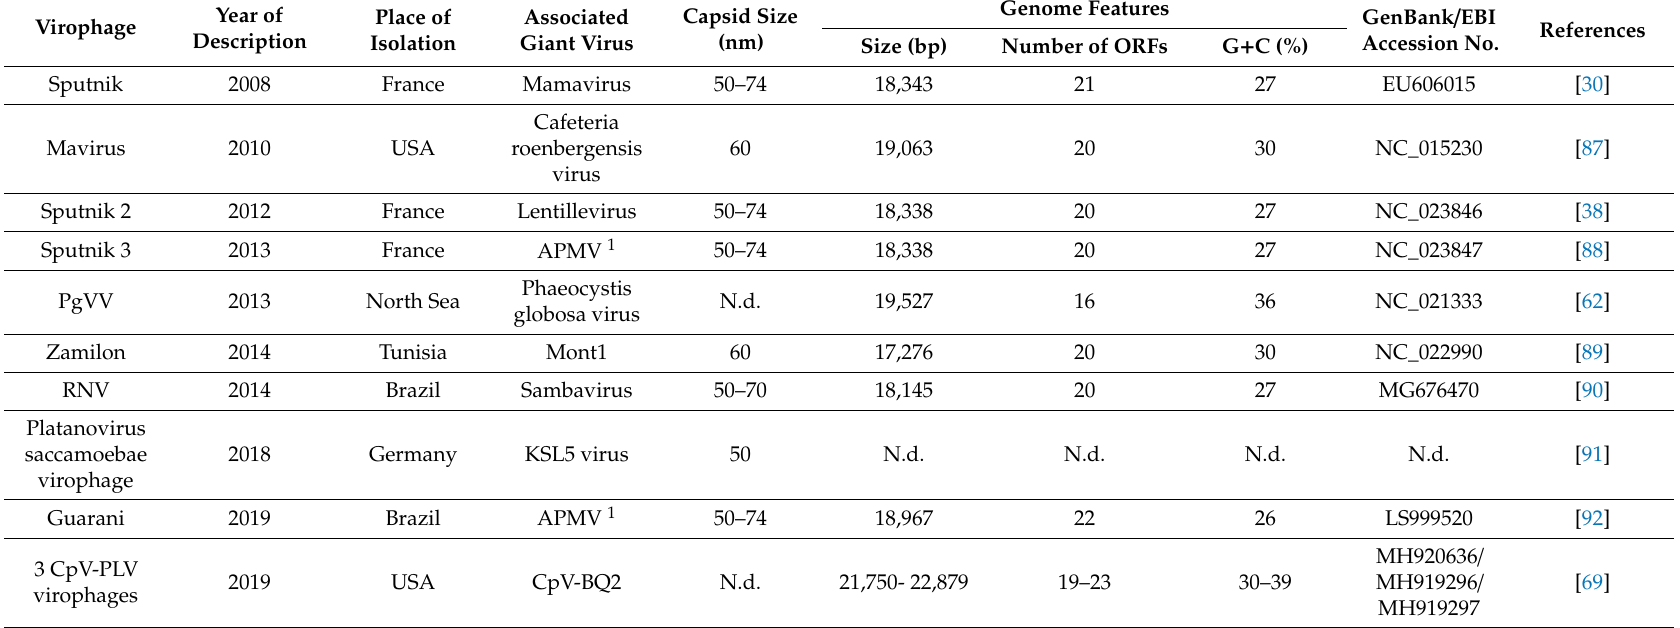
Table 1. Virophages discovered by co-culture and genomic and their main